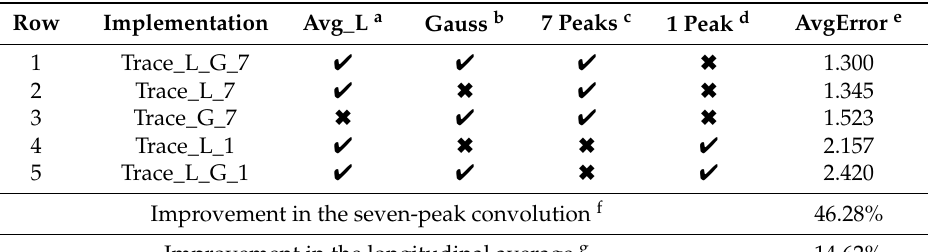
Table 1. The effect of longitudinal averaging, isotropic Gaussian filter, seven-peak 2D convolution, and one-peak 2D convolution on overall accuracy.